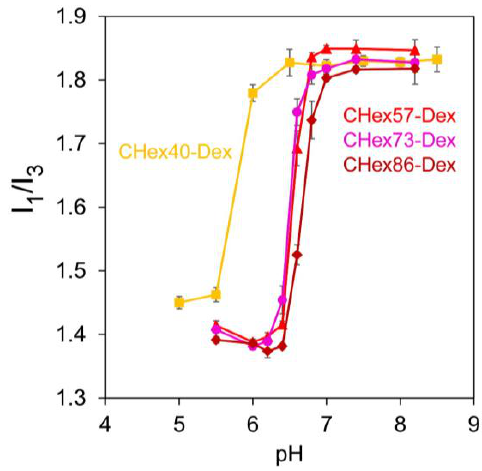
Figure 4. pH-Dependence of I 1 / I 3 of pyrene fluorescence in the presence of dextran derivatives dissolving in 30 mM sodium acetate and 120 mM NaCl solution of varying pH. Concentrations of polymers and pyrene were 0.25 mg/mL and 0.6 μM, respectively. I 1 / I 3 was defined as the fluorescence intensity ratio of the first band at 373 nm to the third band at 384 nm. Next, interaction of dextran derivatives with lipid membrane was investigated. Fluorescence